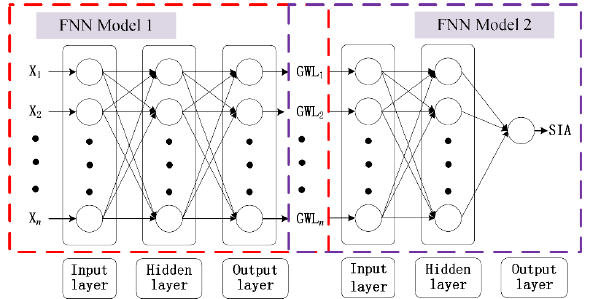
Figure 5. Configuration of the model for SIA simulation.